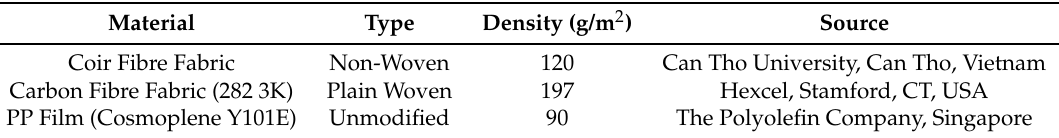
Table 2. Details of the materials used.